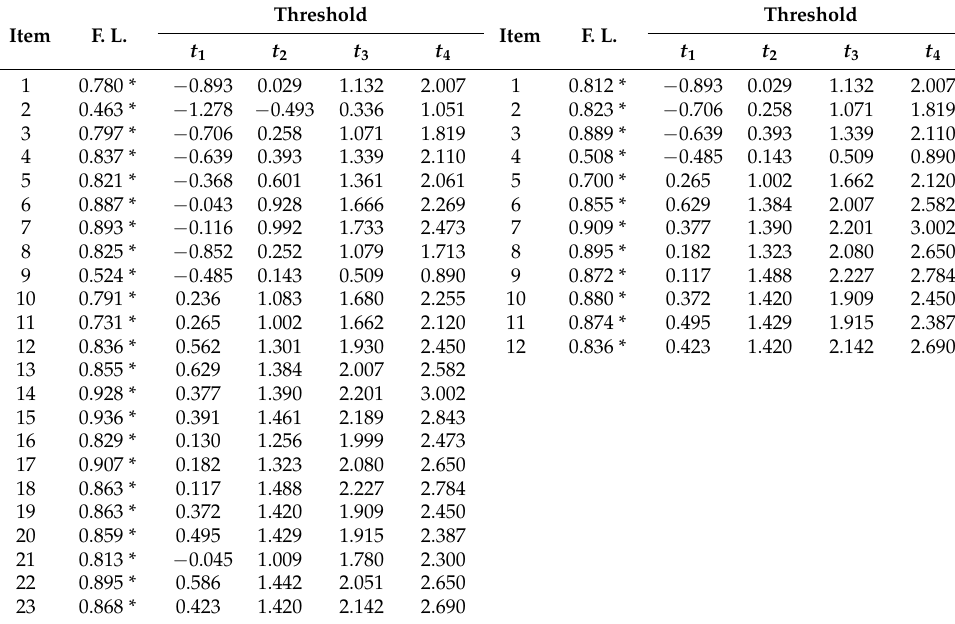
Table 3. Internal consistency analysis.